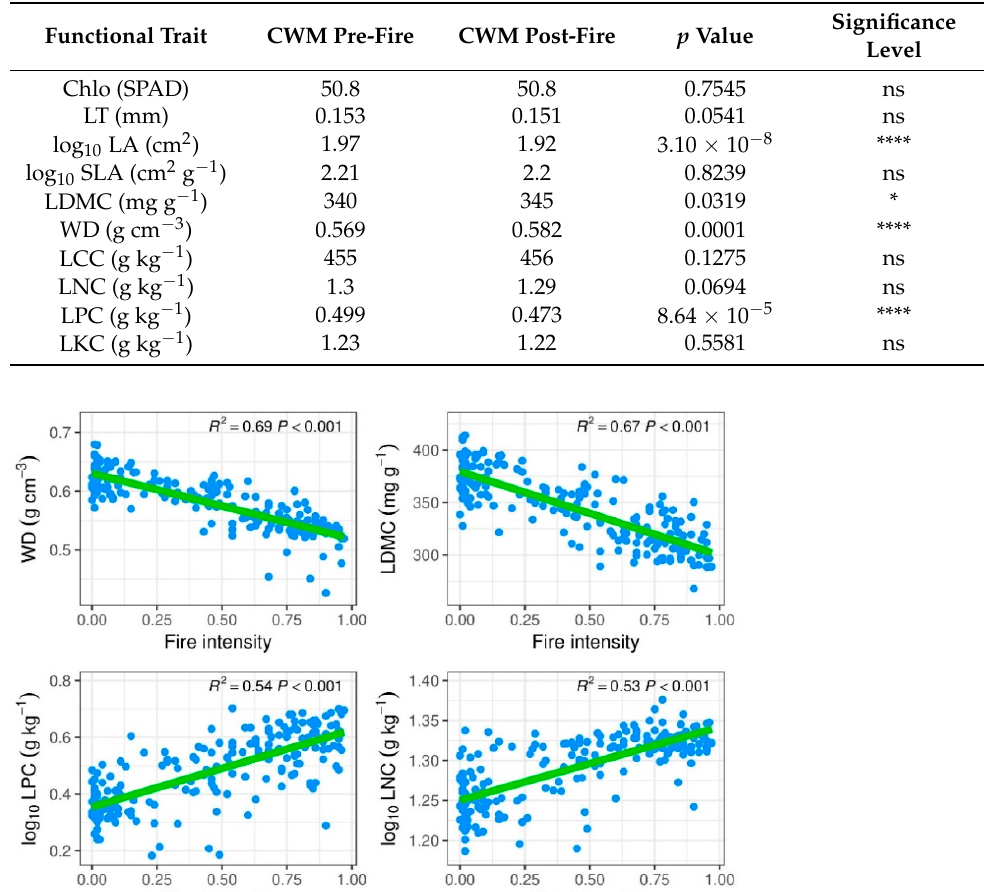
Table 2. Summary of paired sample t-test of community weighted-mean (CWM) of functional traits in Huai Kha Khaeng Forest Dynamics Plot, Thailand. Chlo, Chlorophyll content; LT, leaf thickness; LA, leaf area; SLA, specific leaf area; LDMC, leaf dry matter content; WD, wood density; LCC, leaf total carbon concentration; LNC, leaf total nitrogen concentration; and LPC, leaf total phosphorus concentration. CWM pre-fire shows the mean of CMWs of recruits in 2004 which are derived by 200 50 m × 50 m quadrats and CWM post-fire are accounted by CWMs of recruits in 2009. Asterisks indicate statistically significant difference: n.s. for p > 0.05; * for p ≤ 0.05; **** for p ≤ 0.0001. Functional Trait CWM Pre-Fire CWM Post-Fire p Value